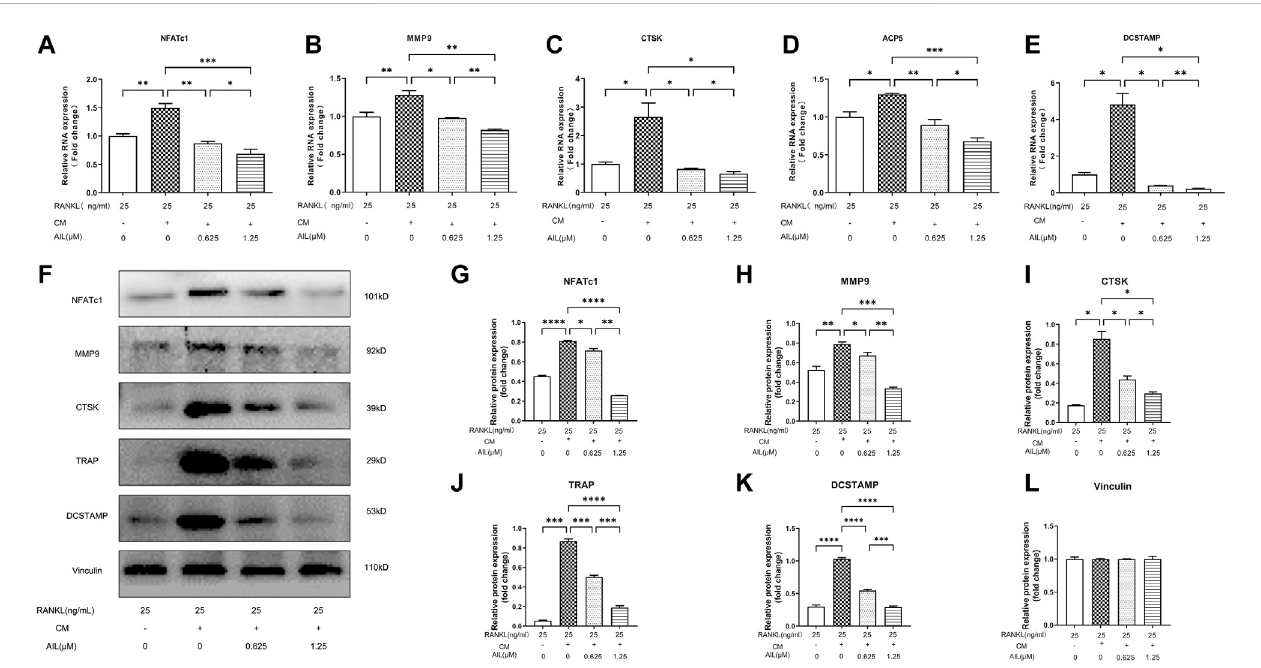
In BMM cells, AIL suppresses the expression levels of the osteoclast-generating genes and protein markers that were simultaneously stimulated by RANKL and MDA-MB-231CM. (A – E) RNA was extracted from BMM cells that had been exposed to various concentrations of AIL, and qPCR was used to determine iftheosteoclast-producing genessuchas NFATc1,CTSK,MMP9,ACP5, andDCSTAMPhadbeen downregulated. The2 ^ ΔΔ CT method wasutilizedto evaluate the data, and Table 1 presents the list of individual primers used in the study. (F) The total protein content was extracted after MDA-MB-231CM treated using various doses of AIL was used to induce BMM cells. Western blot analysis was employed for evaluating the expression of osteoclast-producing protein markers like NFATc1, MMP9, CTSK, TRAP, and DCSTAMP. (G – L) Western blotting experiments were conducted to determine the expression levels of the osteoclast-related proteins following treatment with various doses of AIL. The mean ± SD of the three replicates were used to express all the data. * p < 0.05, ** p < 0.01, *** p < 0.001, **** p < 0.0001, in comparison to the control